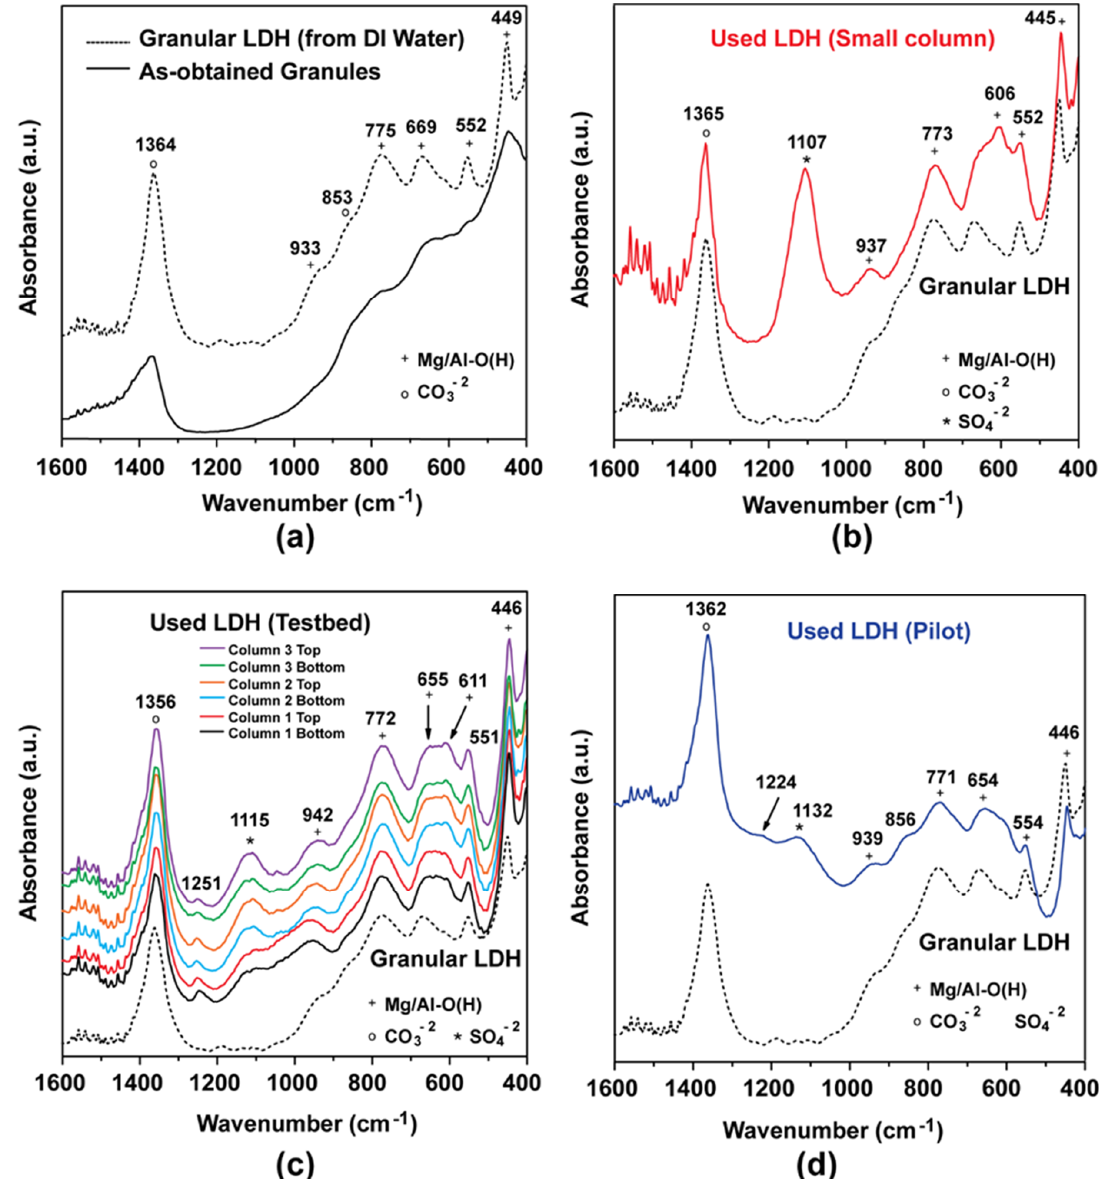
Figure 9. FTIR spectra of ( a ) as-obtained mixed metal oxide granules and used LDH granules from CT blowdown treatment in ( b ) small-scale column test, ( c ) testbed, and ( d ) pilot-scale unit. In each case, the spectrum for the granular LDH (obtained after immersion of the as-obtained granules in DI water purged with N 2 ) is shown for comparison (dashed line).